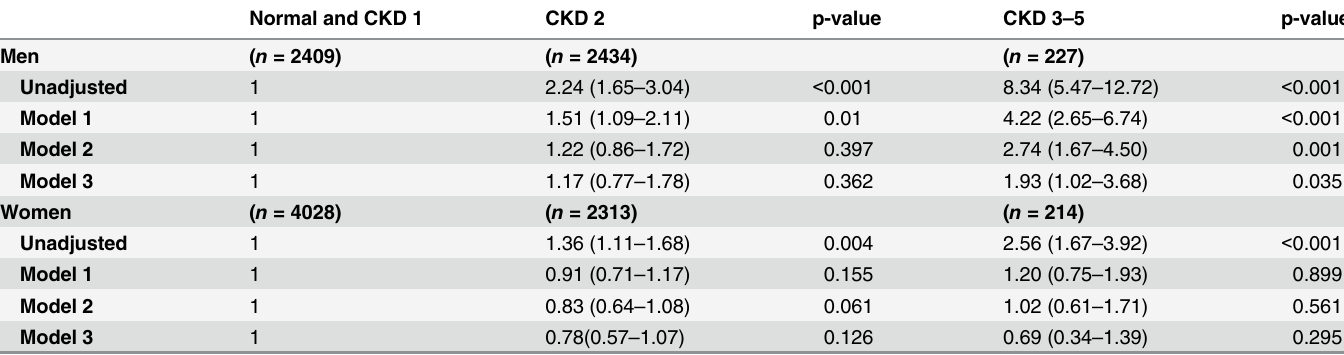
Table 2. Odds ratios of sarcopenia according to stage of chronic kidney